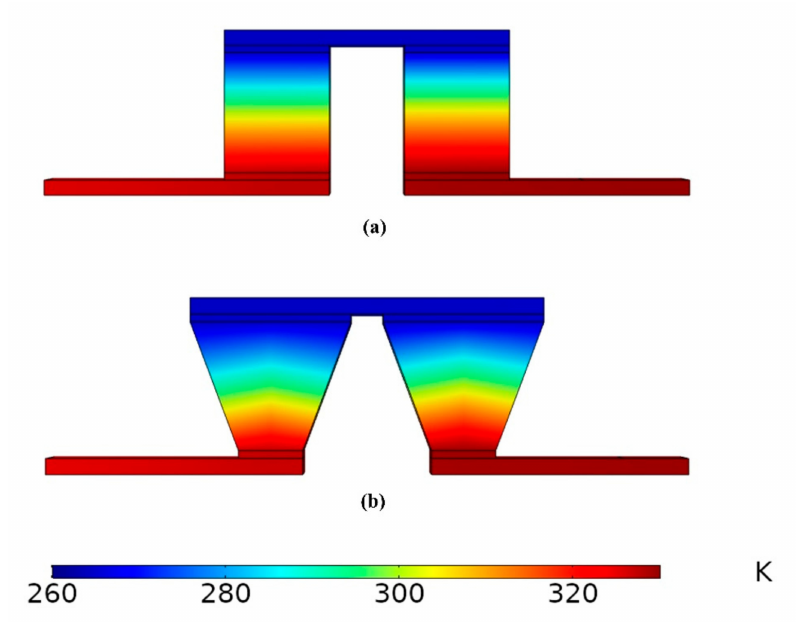
Figure 7. Temperature distributions of thermoelectric legs when H = 1.6 mm: ( a ) R A = 1; ( b ) R A =